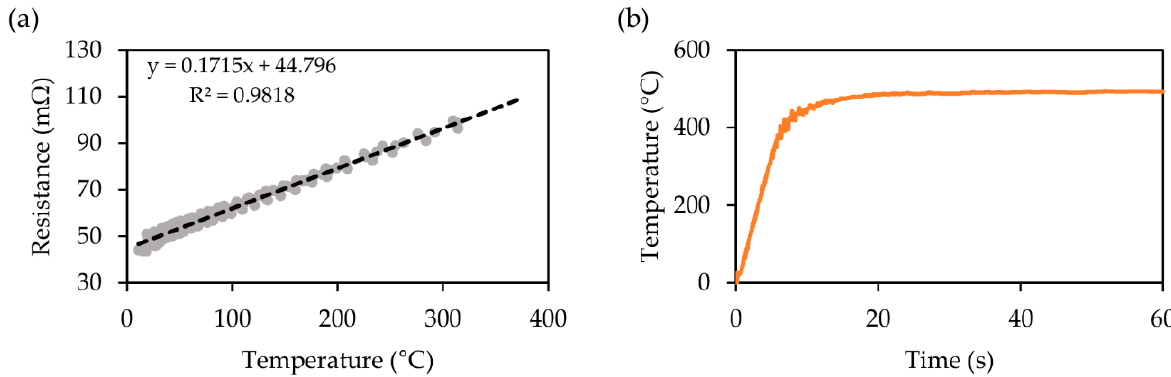
Figure 4. Temperature characteristics of a microheater. ( a ) Calibration of microheater through linear regression. R-squared of the linear regression is 0.9818. ( b ) Temperature–time curves under voltages of 0.5 V, measured based on the relationship between the resistance and temperature of the heater.